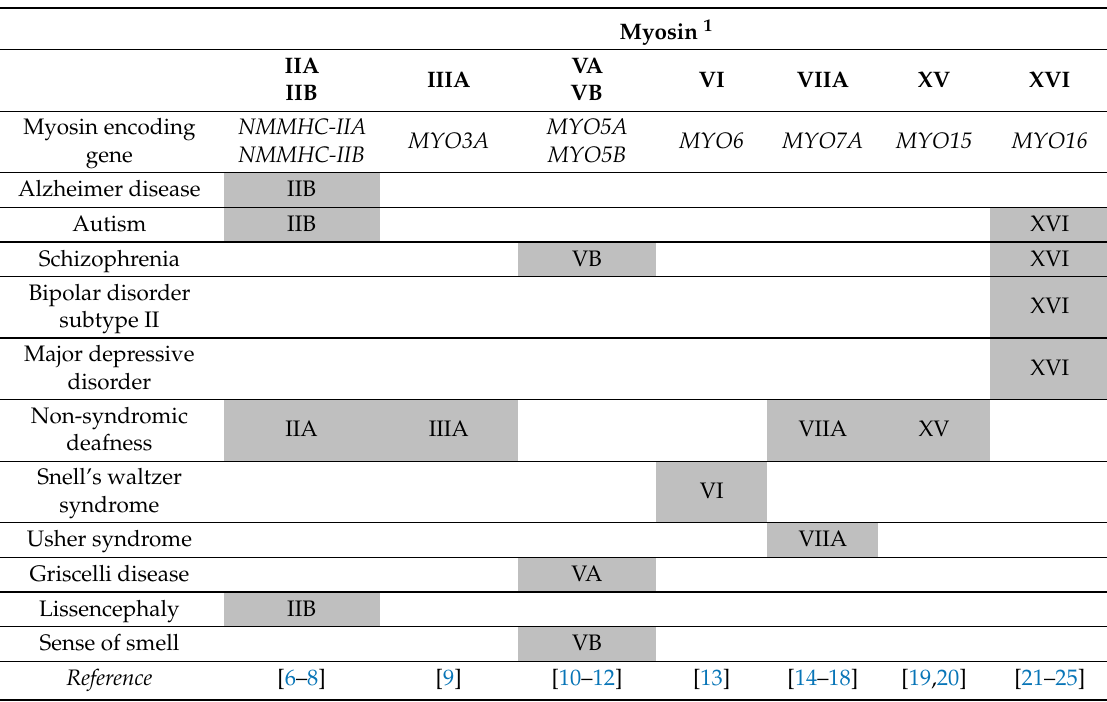
Table 1. Association between di ff erent myosin classes and neurological